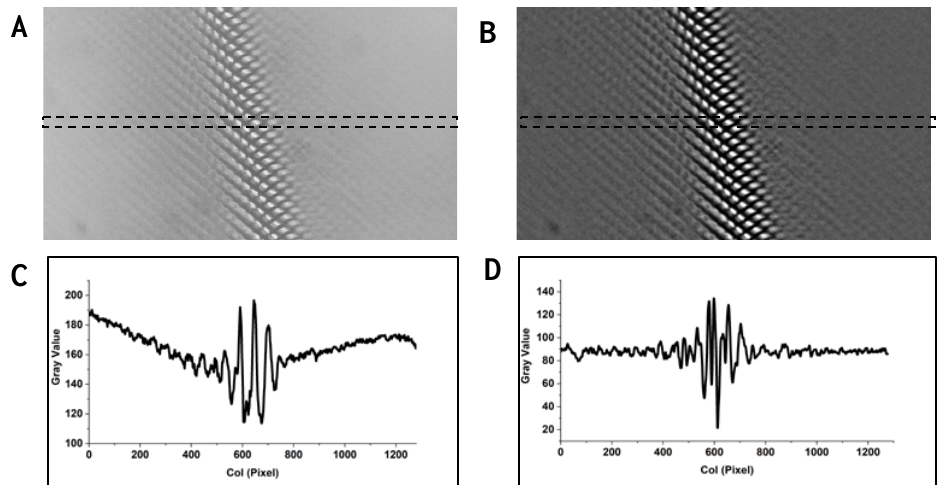
Figure 10. Comparison of the image in the spatial domain and the profile of the selected region before and after processing by bandpass filter. ( A , C ) Before processing by bandpass filter. ( B , D ) After processing by bandpass filter.